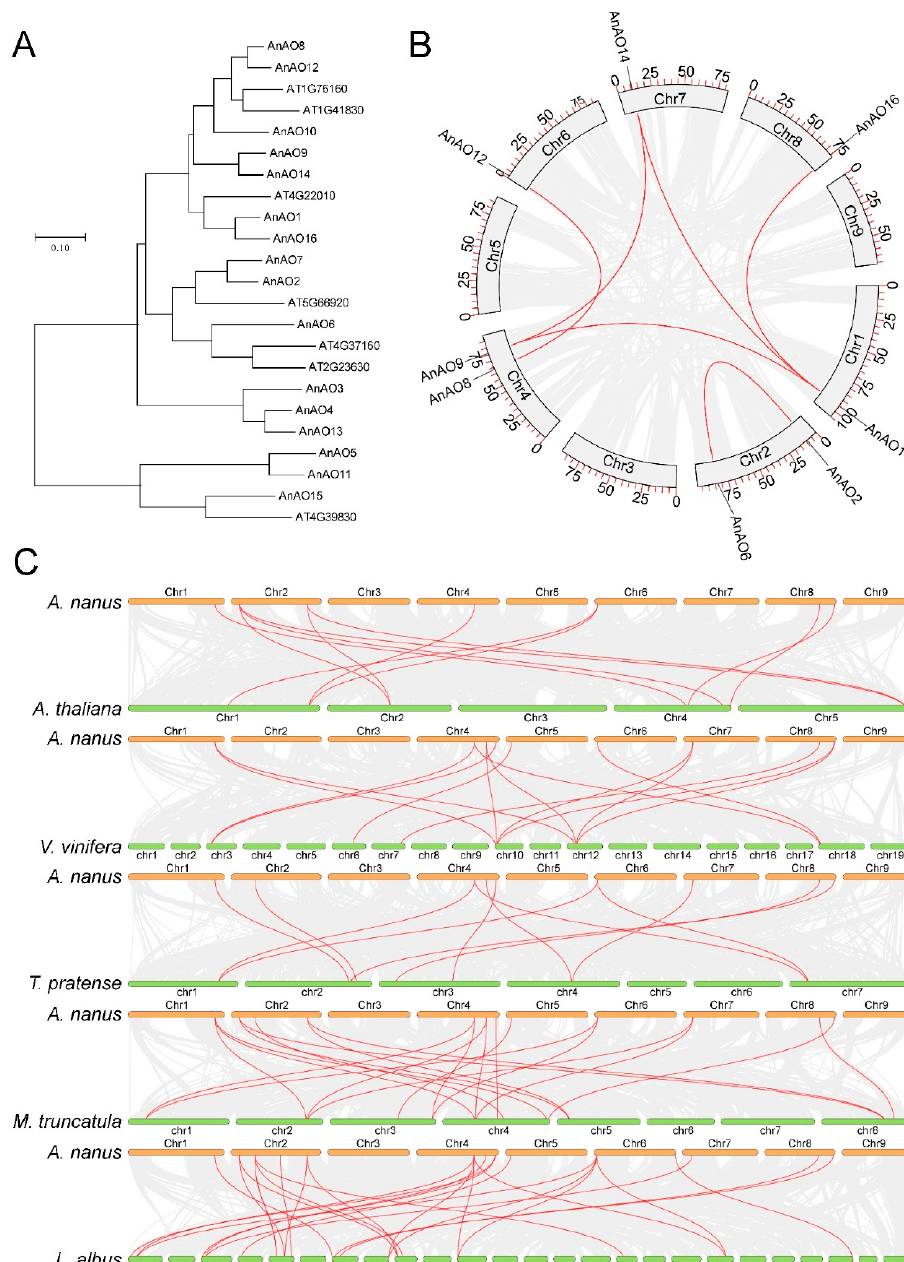
Figure 3. Phylogenetics, and gene duplication and divergence of the AO family in A. nanus . ( A ) The phylogenetic tree of the AnAO family. Different colors represent different plant species, red is A. nanus and black is A. thaliana . ( B ) The distribution of segmental duplication genes of AnAO on the chromosome of A. nanus . ( C ) Homologous gene pairs between A. nanus and V. vinifera , A. thaliana , M. truncatula , T. pratense , and L. albus